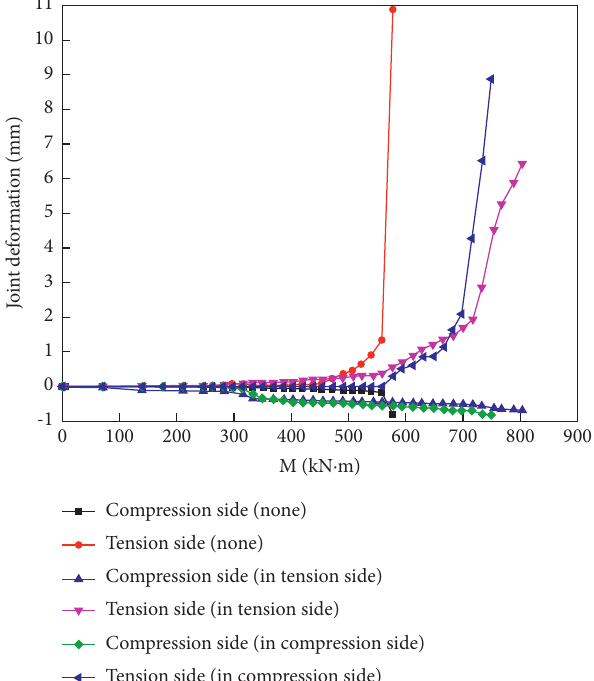
Figure 15: Deformation development of different double-tenon joints (axial force 1000kN).